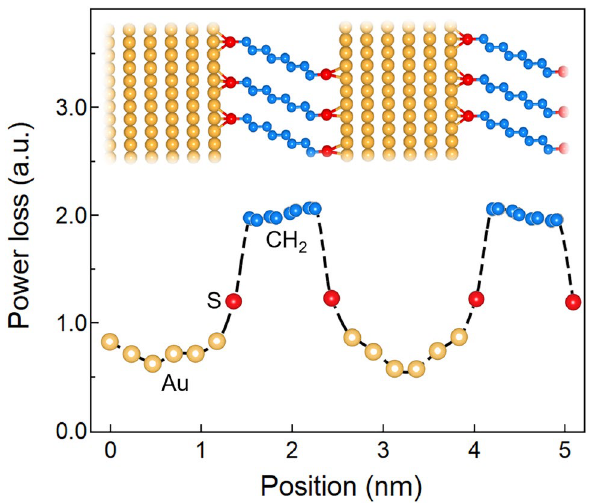
Figure 5. Spatial power loss in Au/octanedithiol MNL/Au multilayers. The energy loss rate was determined for oscillatory shear at 625 GHz corresponding to the maximum loss modulus